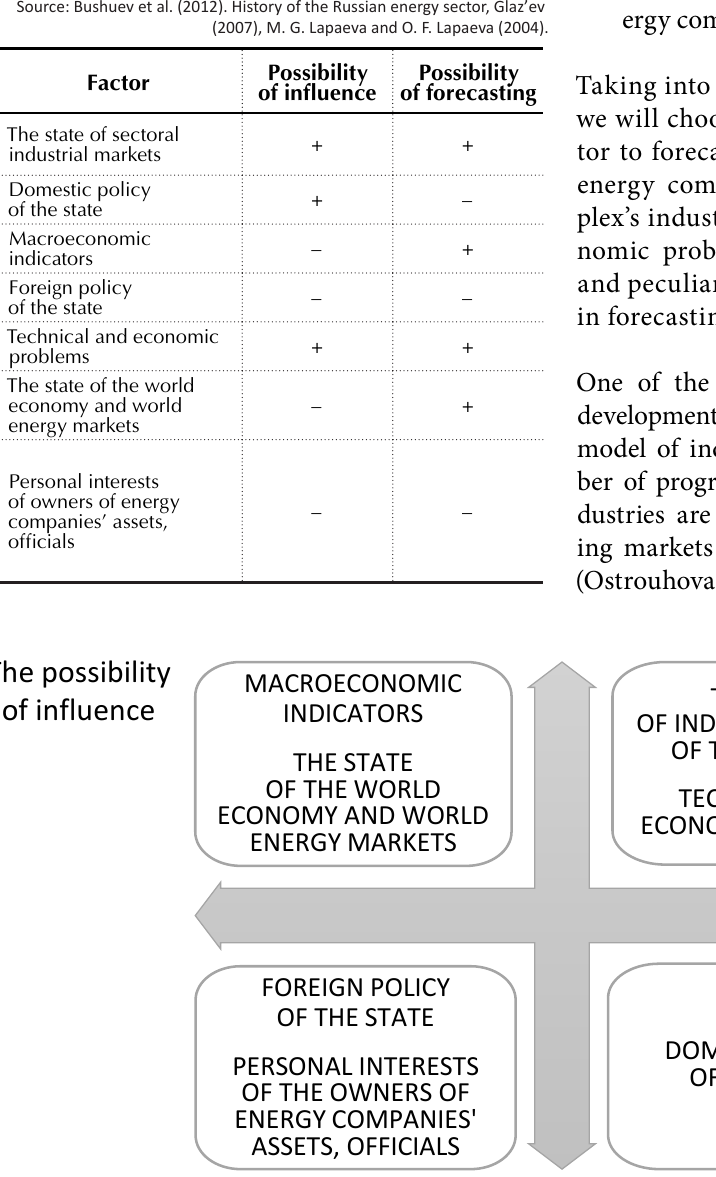
Table 1. Factors determining the development of the fuel and energy complex of Russia